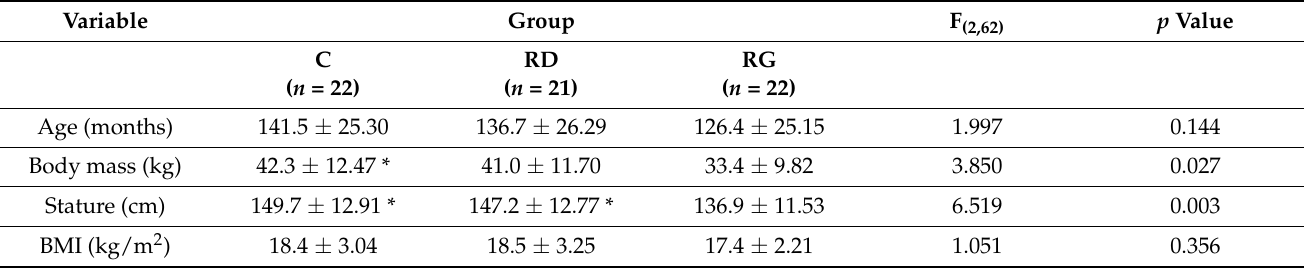
Table 1. Demographic characteristics of the three groups of study participants. One-way ANOVA. Means ± SD.